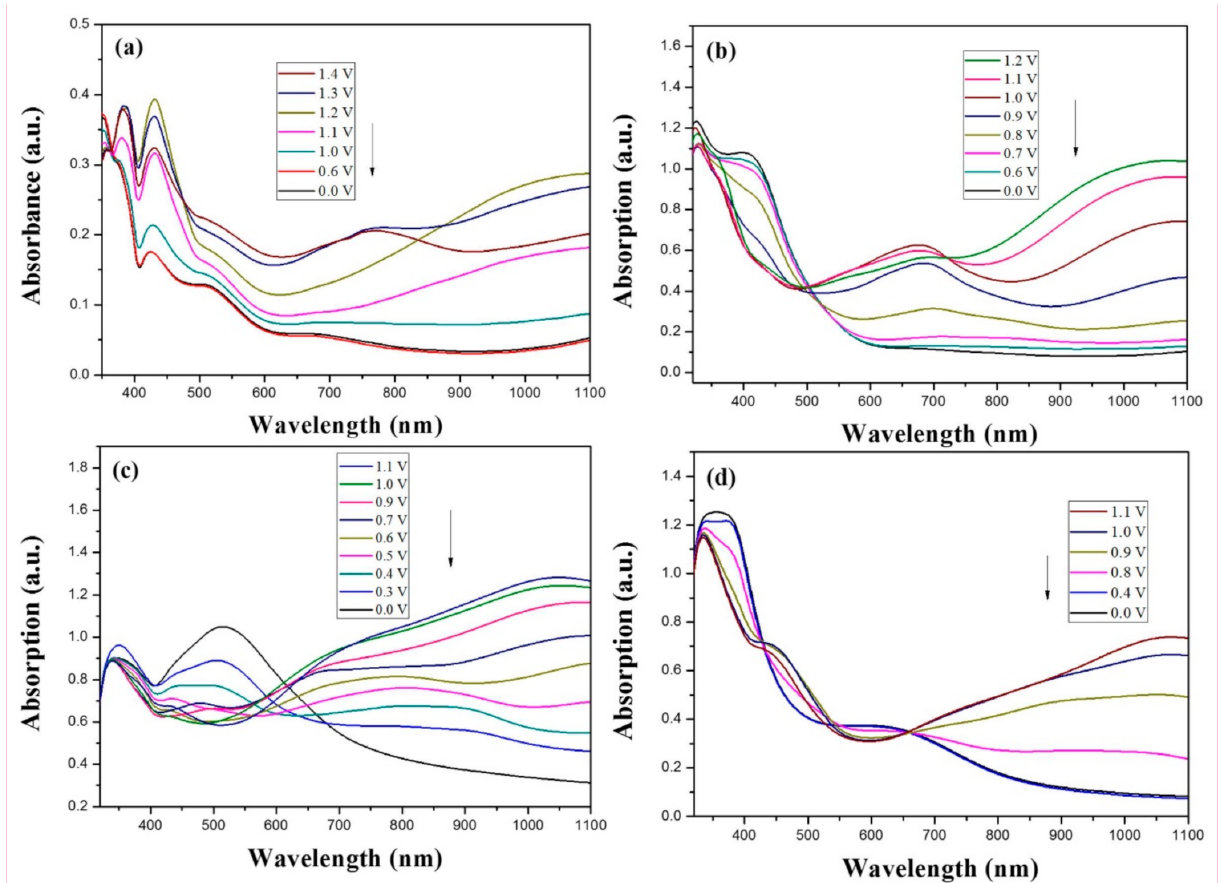
Figure 7. UV–Visible spectra of ( a ) PBPBC, ( b ) P(BPBC- co -BT), ( c ) P(BPBC- co -CDT), and ( d ) P(BPBC- co -CDTK) in 0.2 M LiClO 4 of ACN/DCM solution (ACN/DCM = 4:1, by